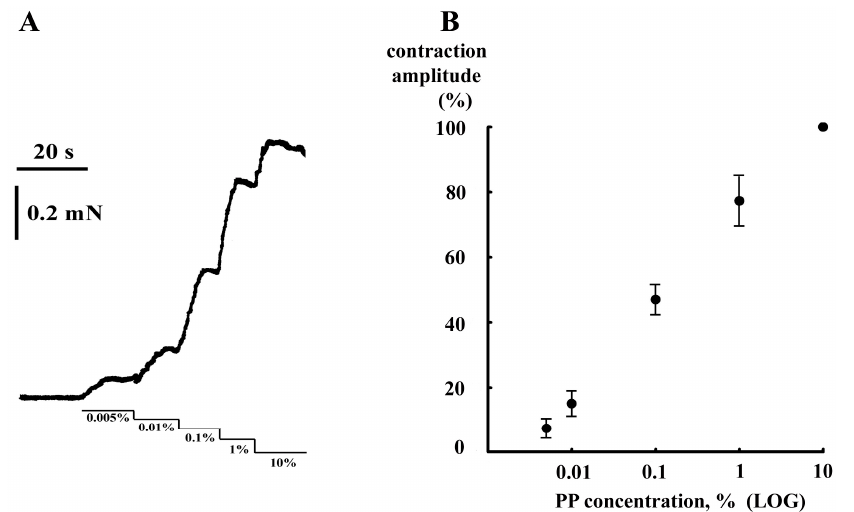
Figure 1. Contractions in rat colon segment in response to cumulative PP application. ( A ) Experimental data of one experiment. The duration and concentrations of PP are shown by horizontal lines under the registration of the contraction. Vertical mark—force of contraction (mN); horizontal—time (s). ( B ) Dose–response curve for four independent experiments. Ordinate—the amplitude of contraction normalized to the contraction induced by 10% PP; abscise—concentration of PP/logarithmic scale (%).